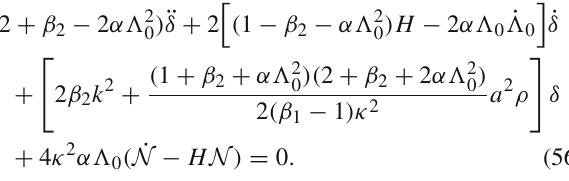
Table 2 The best values of the model parameters β 1 and β 2 , together with the best values of σ 0 values of the parameter η = − 0 . 02 , 0 , 0 . 1 Parameter Best fit value 1 σ confidence level 2 σ confidence